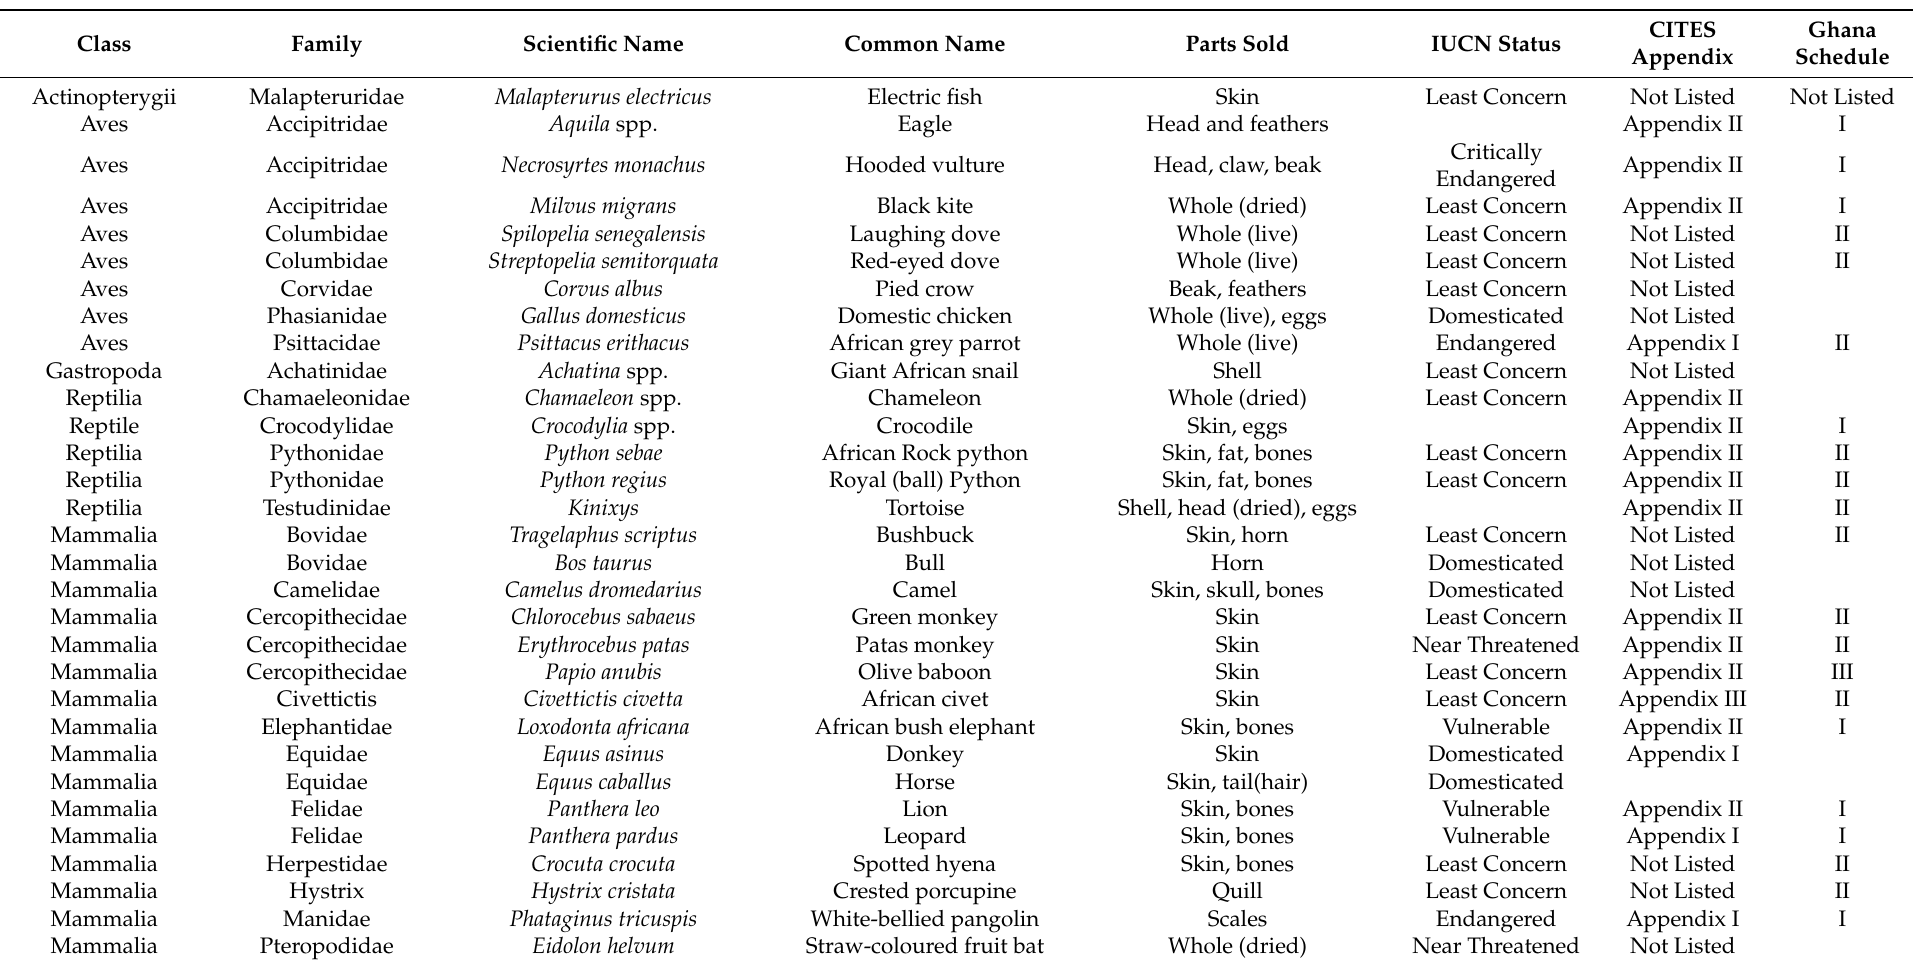
Table 1. Animal species and the body parts traded for traditional medicine purposes in the Kumasi Central Market with their IUCN Status, CITES Appendices and Conservation Schedule in